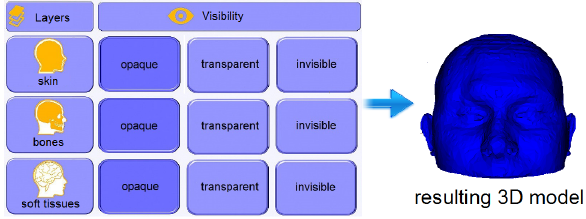
Fig. 10: In (a) and (b), different configurations of visibility for generating 3D